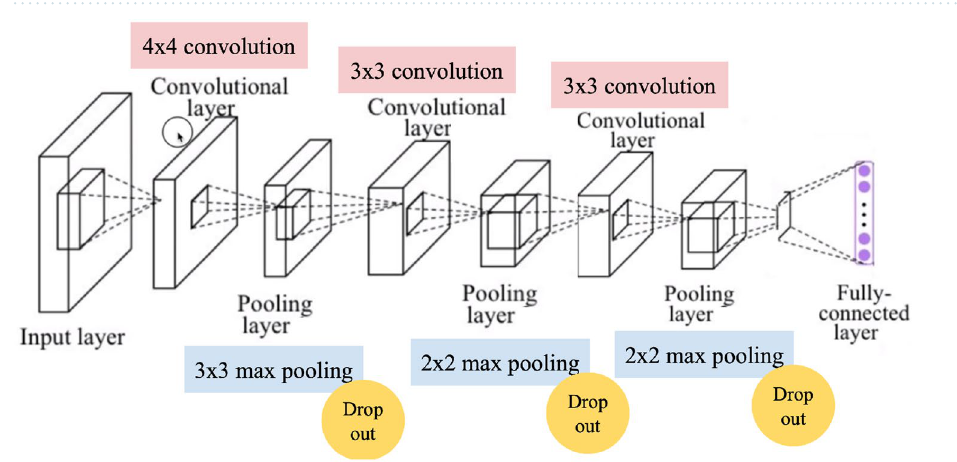
Figure 4. ( A ) PCA performed on data obtained by analyzing control (green) and BC (red) human urine with a GC–MS. ( B ) Figure on the right is a zoom of the figure on the left. ( C ) PCA performed on data obtained by analyzing control (green) and BC (red) human urine with the eNose prototype. ( D ) Figure on the right is a zoom of the figure on the left.